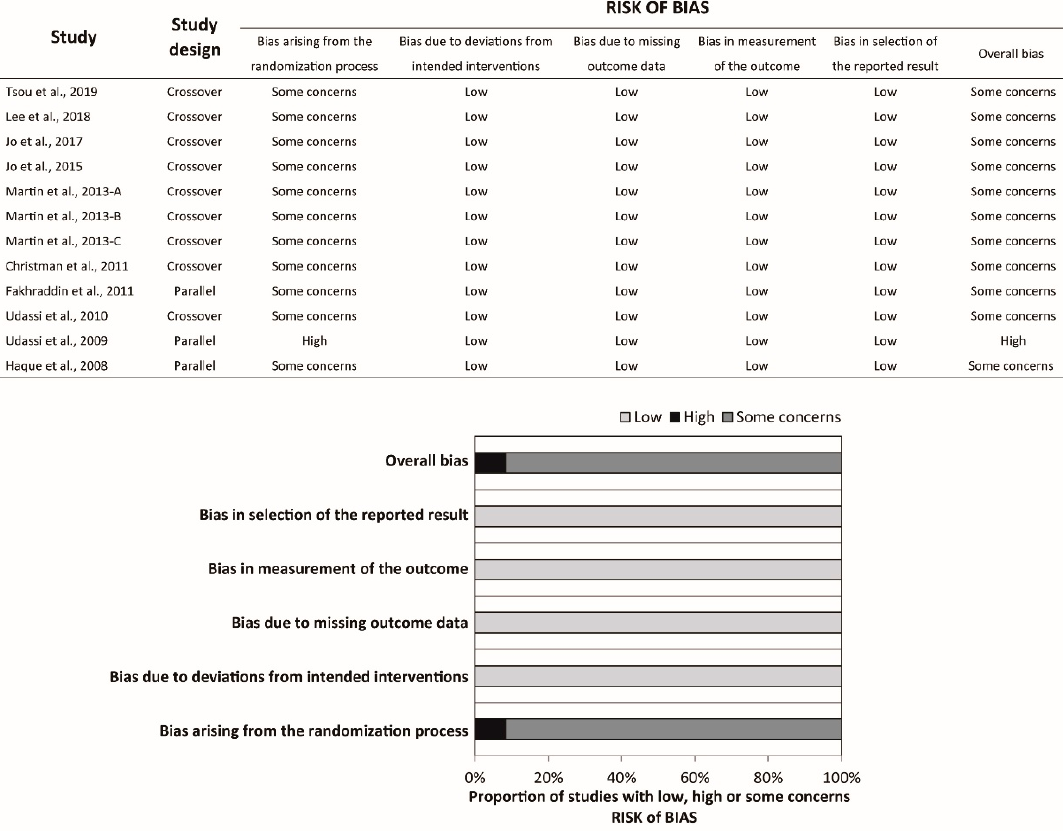
Figure 2. Risk of bias summary and graph of chest compression rate.